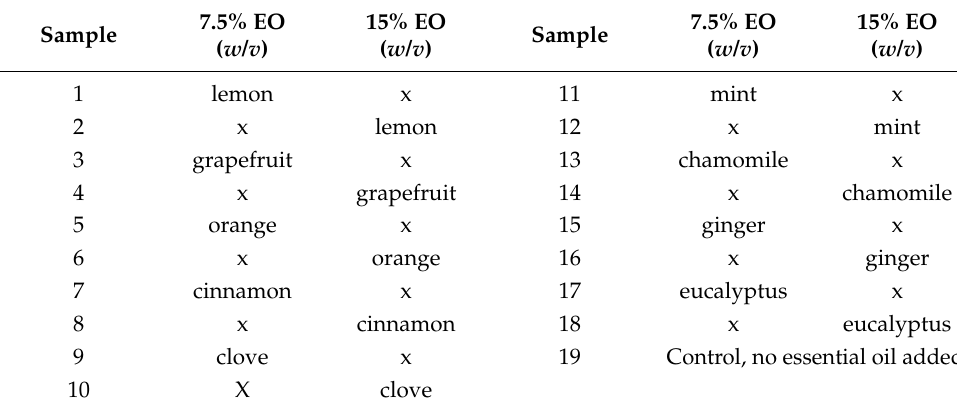
Table 4. Composition of new biopolymer-based